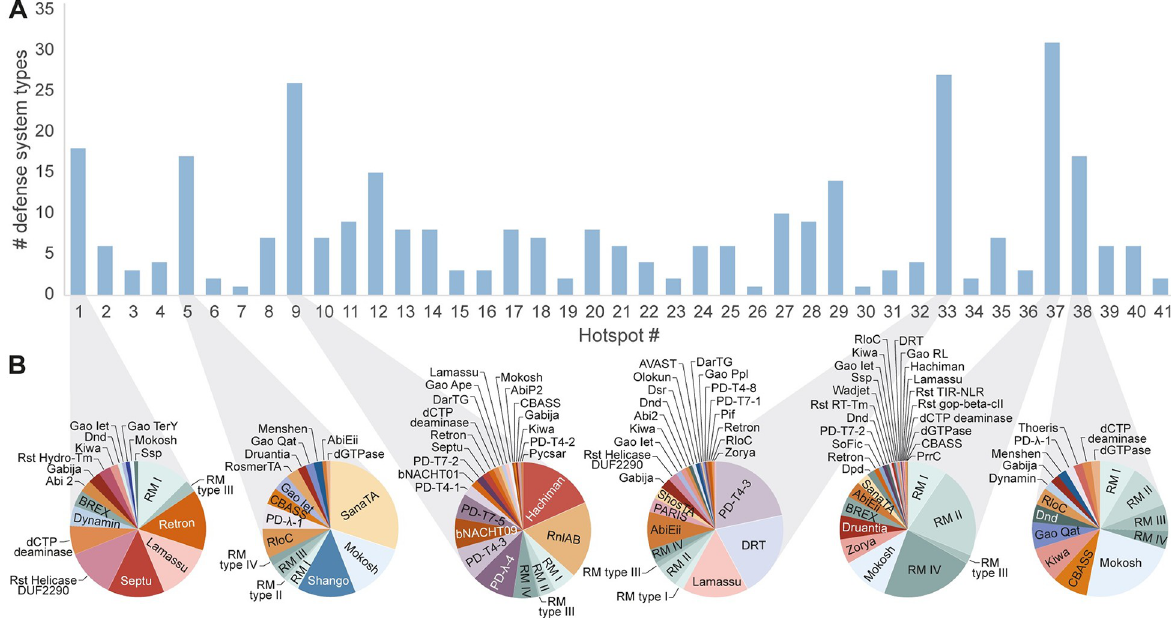
Fig 5. Diversity of defense systems at E . coli hotspots. (A) Number of different defense systems found at each of the 41 hotspots mapped in this study. (B) Defense system distribution for a selected set of the most diverse hotspots.